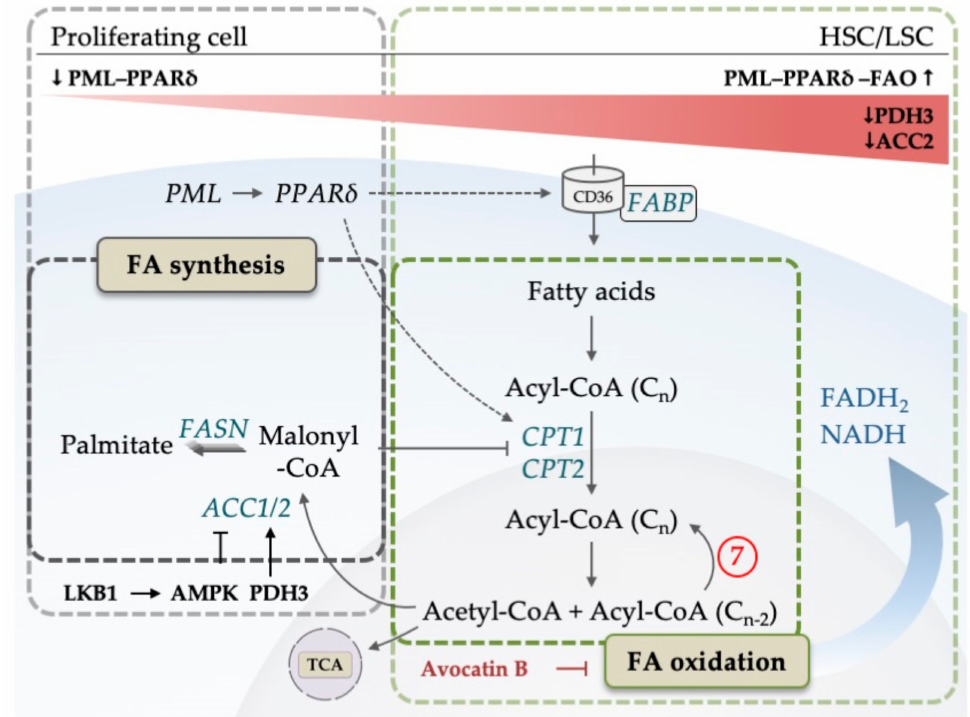
Figure 7. Simplified model of fatty acid (FA) metabolism. Fatty acid synthesis (FAS) starts after acetyl-CoA is converted to malonyl-CoA by ACC. Malonyl-CoA is then further processed by FAS. On the right hand side, fatty acid oxidation (FAO) of acyl-CoA begins after fatty acids are transported into the cell by CD36 and converted to acyl-CoA. The translocation of acyl-CoA into the mitochondria is facilitated by CPT1 / 2. Avocatin B accumulates in mitochondria to inhibit FAO. While proliferating cells show elevated FAS for the generation of membranes, HSCs / LSCs upregulate FAO to maintain quiescence controlled by PML-PPAR δ -FAO axis. PDH3, which is downregulated in AML, promotes FAO by decreasing ACC2 activity. LKB1-AMPK pathway inhibits ACC proteins and promotes FAO. Dotted lines indicate target genes of PPAR δ . Abbreviations: ACC, acetyl-CoA carboxylase; AMPK, adenosine monophosphate (AMP)-activated kinase; CoA, Coenzyme A; CD, cluster of di ff erentiation; CPT, carnitine palmitoyltransferase; FA, fatty acid; FABP, fatty acid binding protein; FADH 2 , flavin adenine dinucleotide; FAO, fatty acid oxidation; FASN, fatty acid synthase; HSC, hematopoietic stem cell; LSC, leukemic stem cell; LKB1, liver kinase B1; NADH, nicotinamide adenine dinucleotide; PDH3, Prolyl hydroxylase 3; PML, promyelocytic leukemia; PPAR δ , Peroxisome proliferator-activated receptor; TCA, tricarboxylic acid. Circled numbers refer to metabolic response determinants in AML that are discussed in the Conclusion